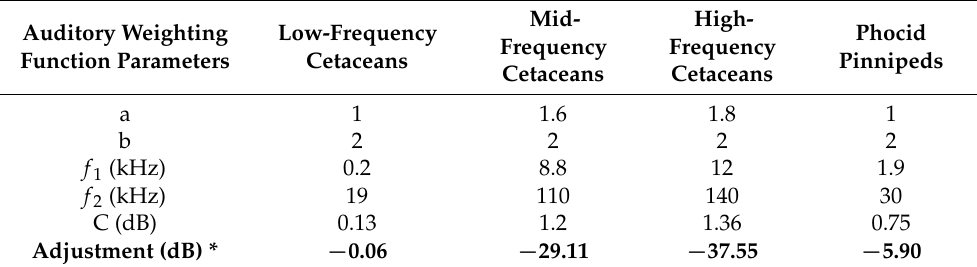
Table 3. Auditory weighting function parameters for cetacean and pinniped hearing groups for use in steady state exposures to explosives (* assumes a weighting factor adjustment frequency of 1 kHz as for seismic